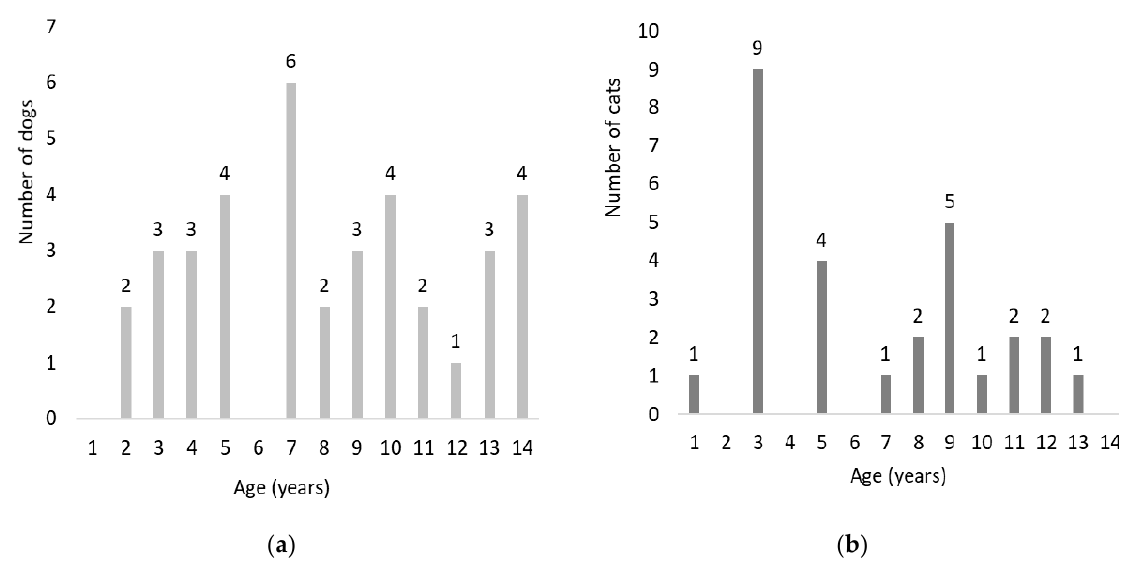
Figure 1. ( a ) Age distribution in the dog population; ( b ) age distribution in the cat population.